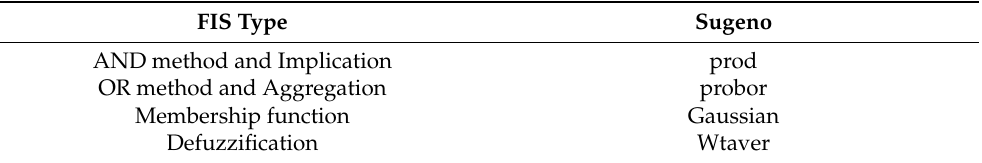
Table 2. Fuzzy parameters.